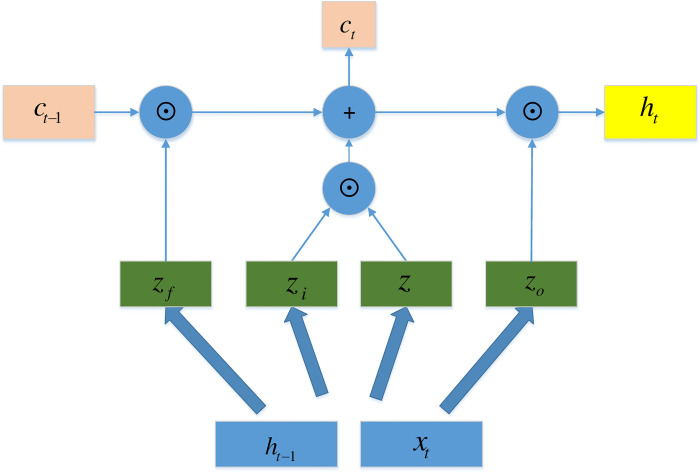
Diagram of the LSTM.